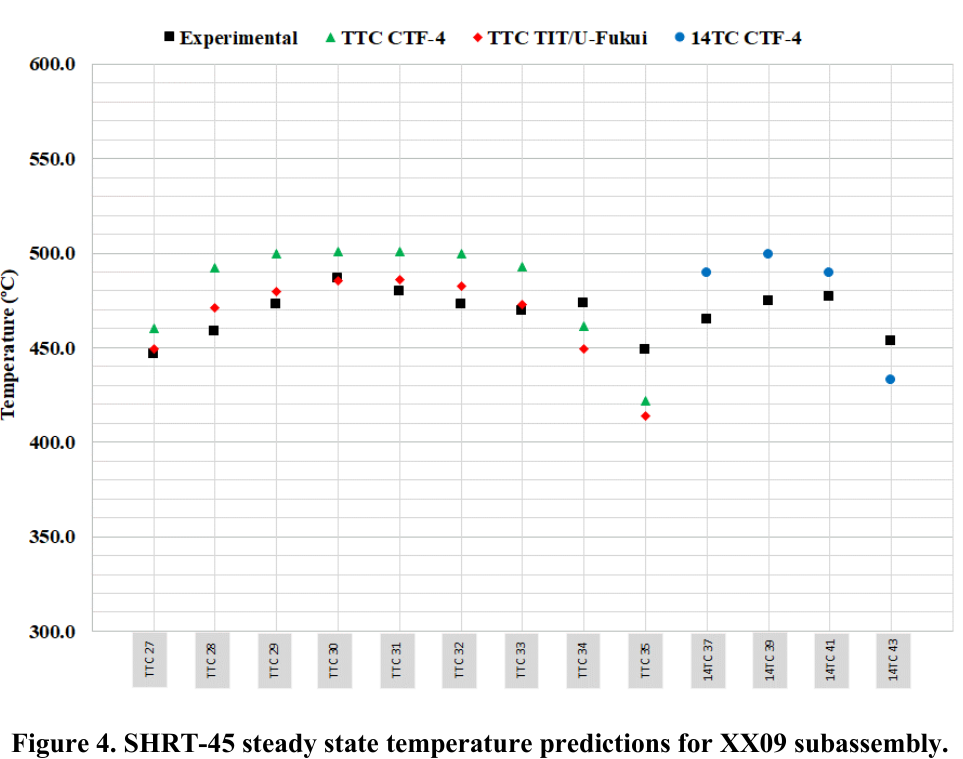
Figure 4. SHRT-45 steady state temperature predictions for XX09 subassembly.